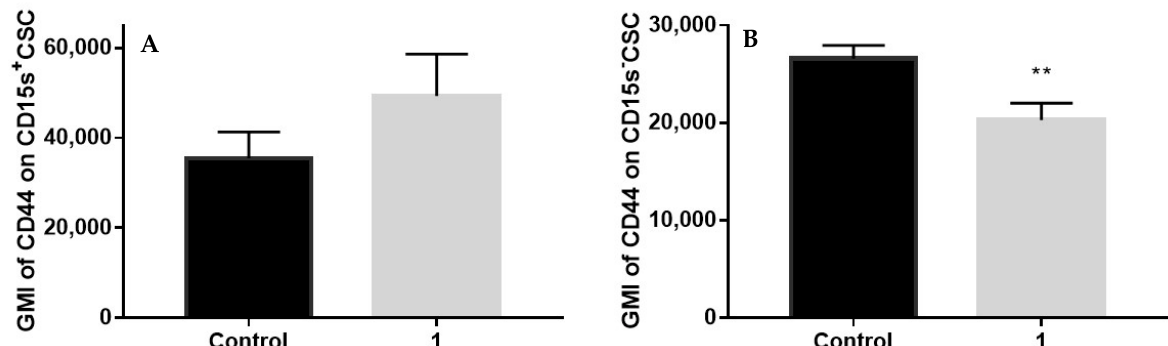
Figure 9. Expression of CD44 in CSC positive and negative for CD15s after treatment with compound 1 . Notes: geometric mean fluorescence intensity of CD44 in CD15s + CSC ( A ) and CD44 in CD15s − CSC ( B ) after treatment with compound 1 . Data are expressed as a mean from experiment performed in triplicate ± SD. Columns, mean of cells; bars, SD; ** p < 0.01. Abbreviations: CSC, cancer stem cells; GMI, geometric mean fluorescence intensity.